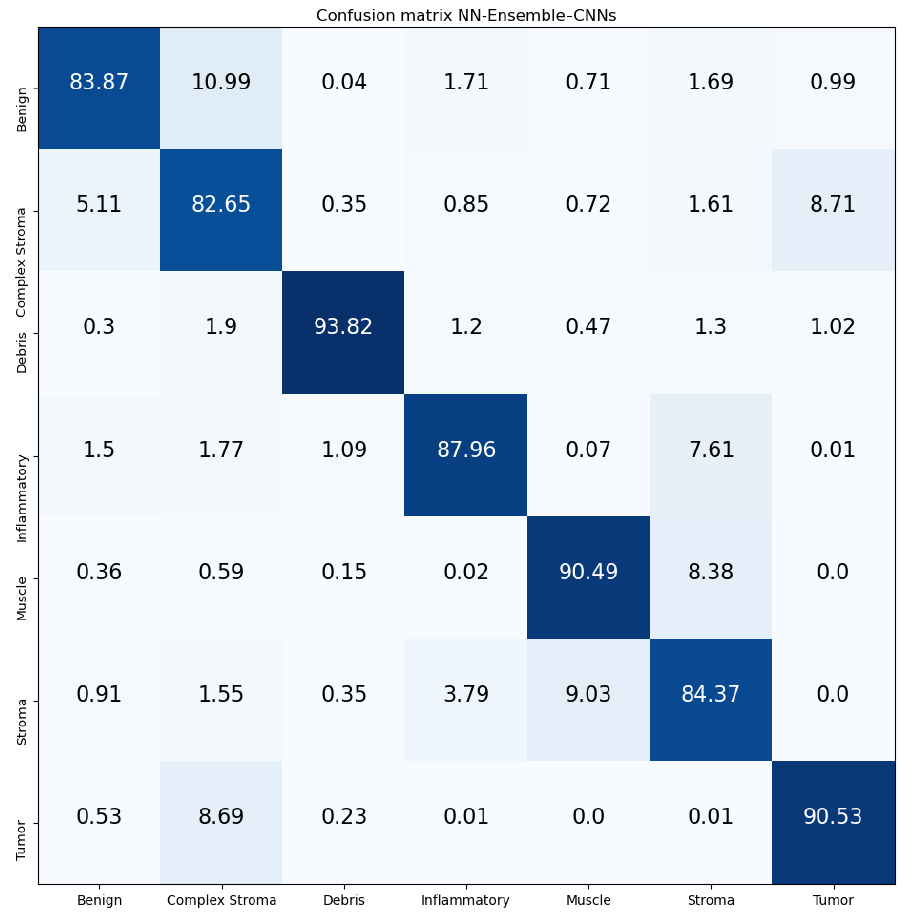
Figure 17. Confusion Matrix of NN-Ensemble-CNNs on CRC-TP database. The vertical axis is for the true classes, and the horizontal axis is for the predicted classes.